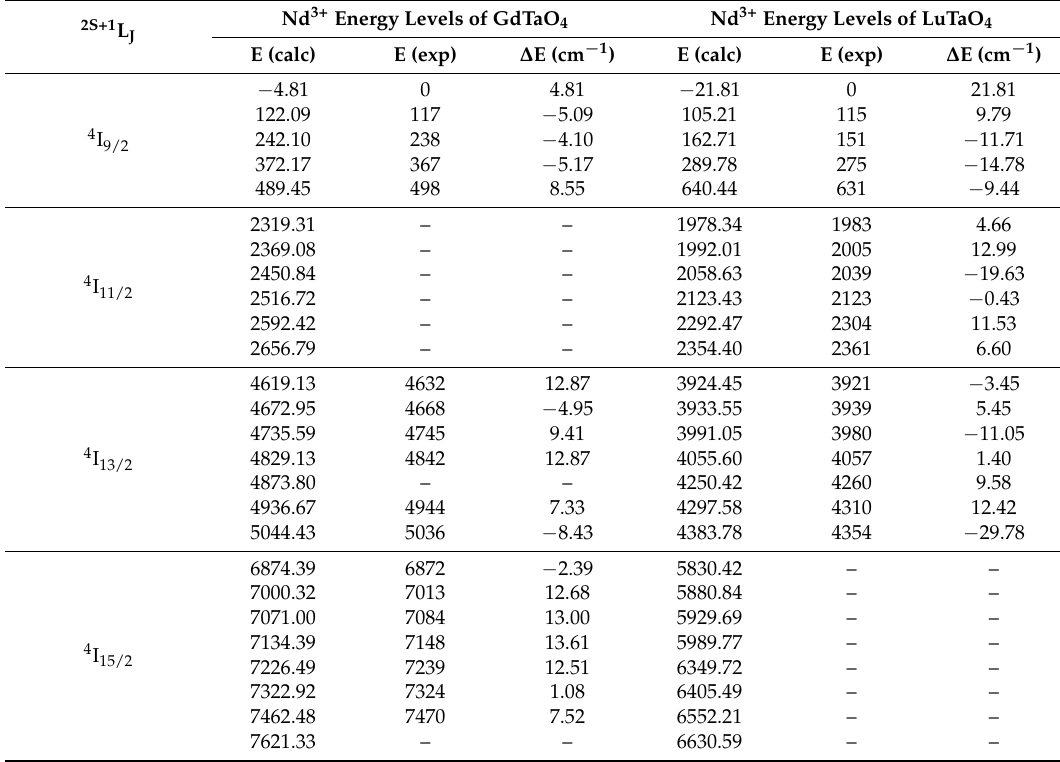
Table 9. Energy levels of Nd 3+ in rare earth